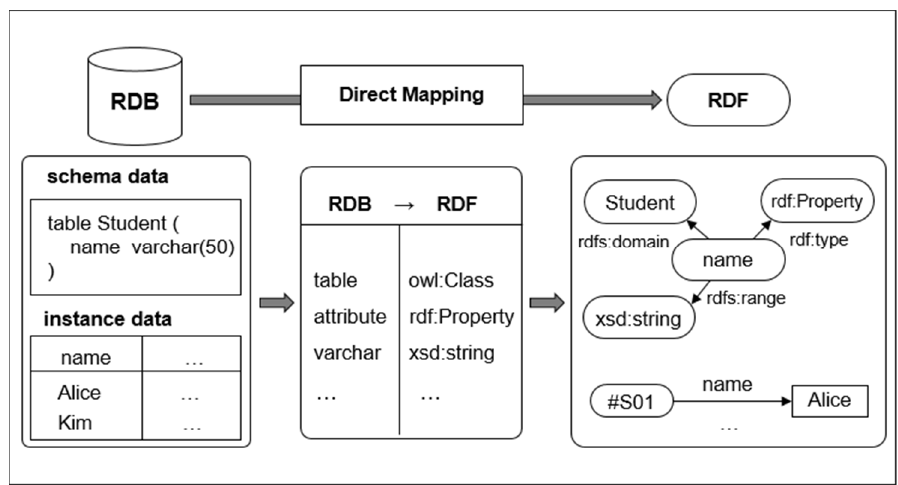
Figure 1. A simplified example of direct mapping. RDB represents relational database, RDF represents resource-description-framework.